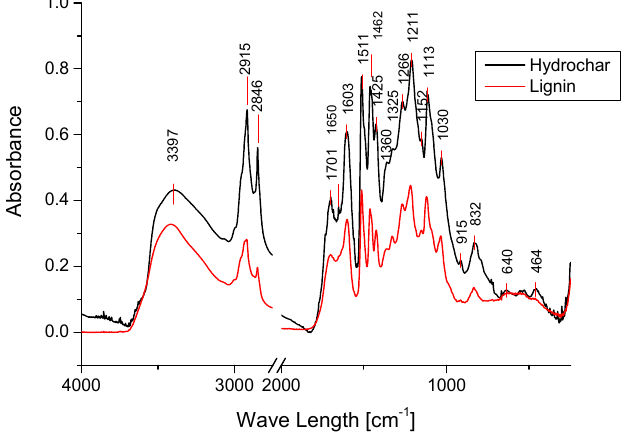
Energies 2018 , 11 , x 8 of 12 plus the ν (C–H)-band at 2900 cm − 1 suggests a dehydration and partial aromatization of the material during thermal treatment. The results reported here are in accordance with other studies, e.g., [9,23].